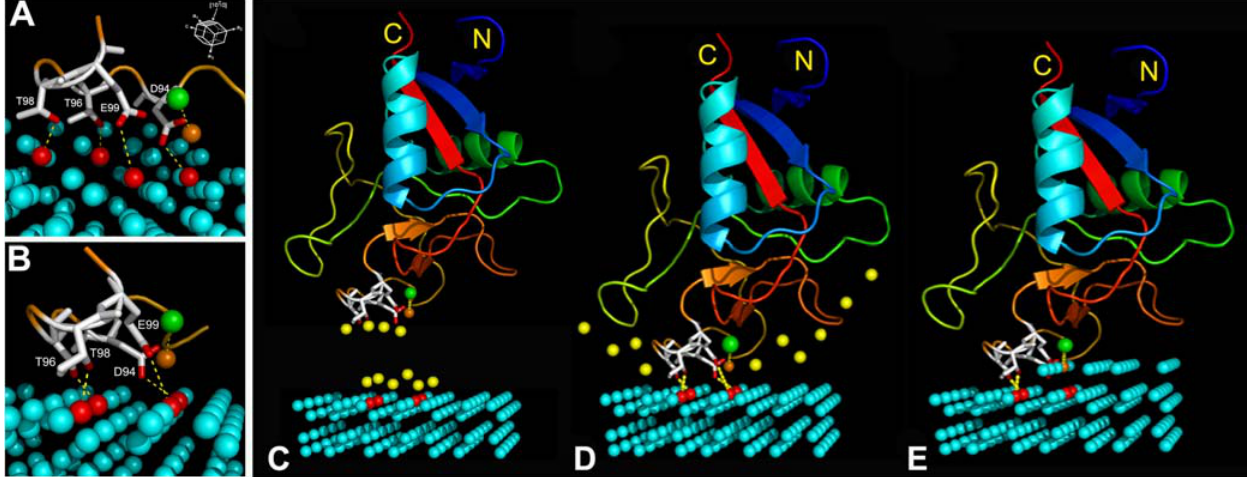
Figure 8. A model for hAFP binding to [10-10] prism plane of ice. (A) and (B) show that four ice-binding residues Asp94, Thr96, Thr98, and Glu99 form hydrogen bonds with water molecules of the ice lattice (highlighted in red) through respective side-chain oxygen atoms as indicated by yellow dotted lines. The Ca 2 + ion is shown as a green sphere. The water molecule coordinating with the Ca 2 + ion is shown as an orange sphere. The orientation of the ice lattice and the [10-10] prism plane are indicated. (C) Yellow spheres represent the water molecules constrained at the hAFP ice- binding face and the ice-water interface. (D) When hAFP binds to ice, constrained water molecules are released. This is considered as an entropy favorable process. (E) With the growth of the second layer of ice on the prism plane, the Ca 2 + -coordinating water molecule is incorporated into the ice lattice, thus the hAFP-ice interaction is further stabilized. This diagram was generated using PyMOL [41].